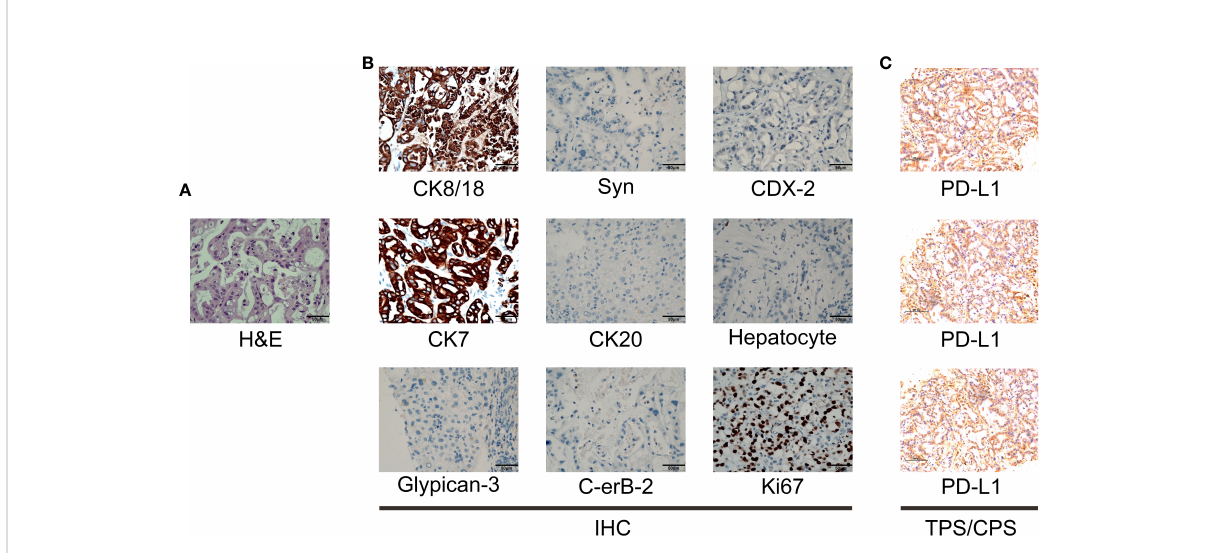
FIGURE 2 Pathological examination results. (A) The hematoxylin-eosin (H&E) staining in the microscopic observation (400×). (B) IHC of liver metastases of pancreatic ductal adenocarcinoma showed CK8/18+, Syn-, CDX-2-, CK7+, CK20-, Hepatocyte-, Glypican-3-, C-erB-2(0), Ki67 (60%+), original magni fi cation ×400. (C) PD-L1 IHC staining of hepatic metastases tested that the Tumor cell Proportion Score (TPS) is 2-4, and the Combined Positive Score (CPS) is